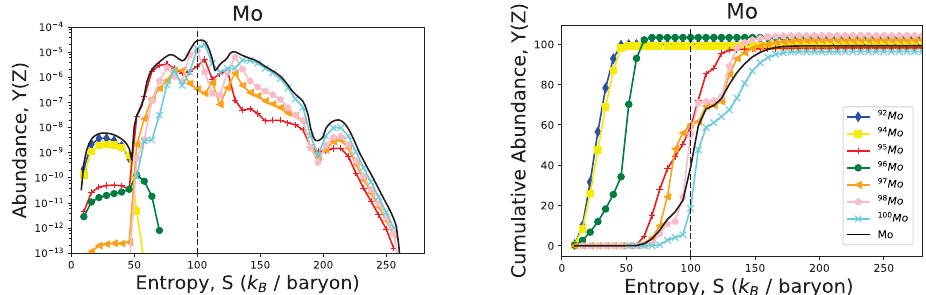
Fig. 1. Isotopic yields (left) and cumulative isotopic yields (right) for Mo as a function of cumulative entropy bins, for the case Y e = 0.45. CP component (S ≤ 100) and n-capture component (S >